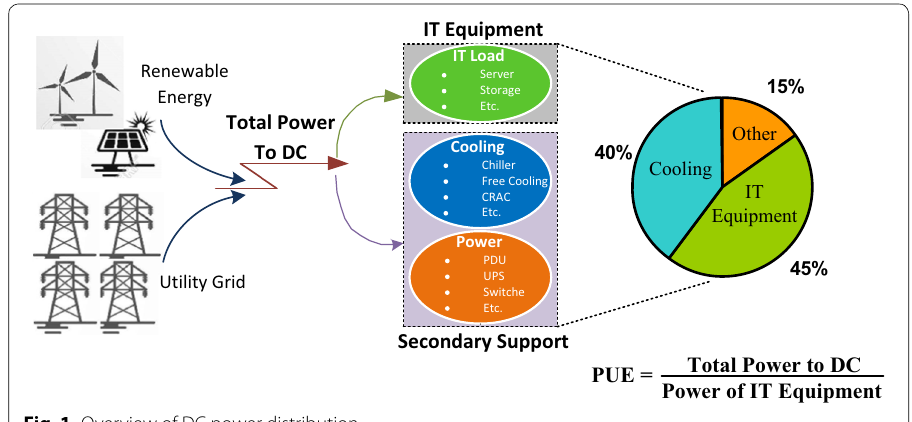
Fig. 1 Overview of DC power